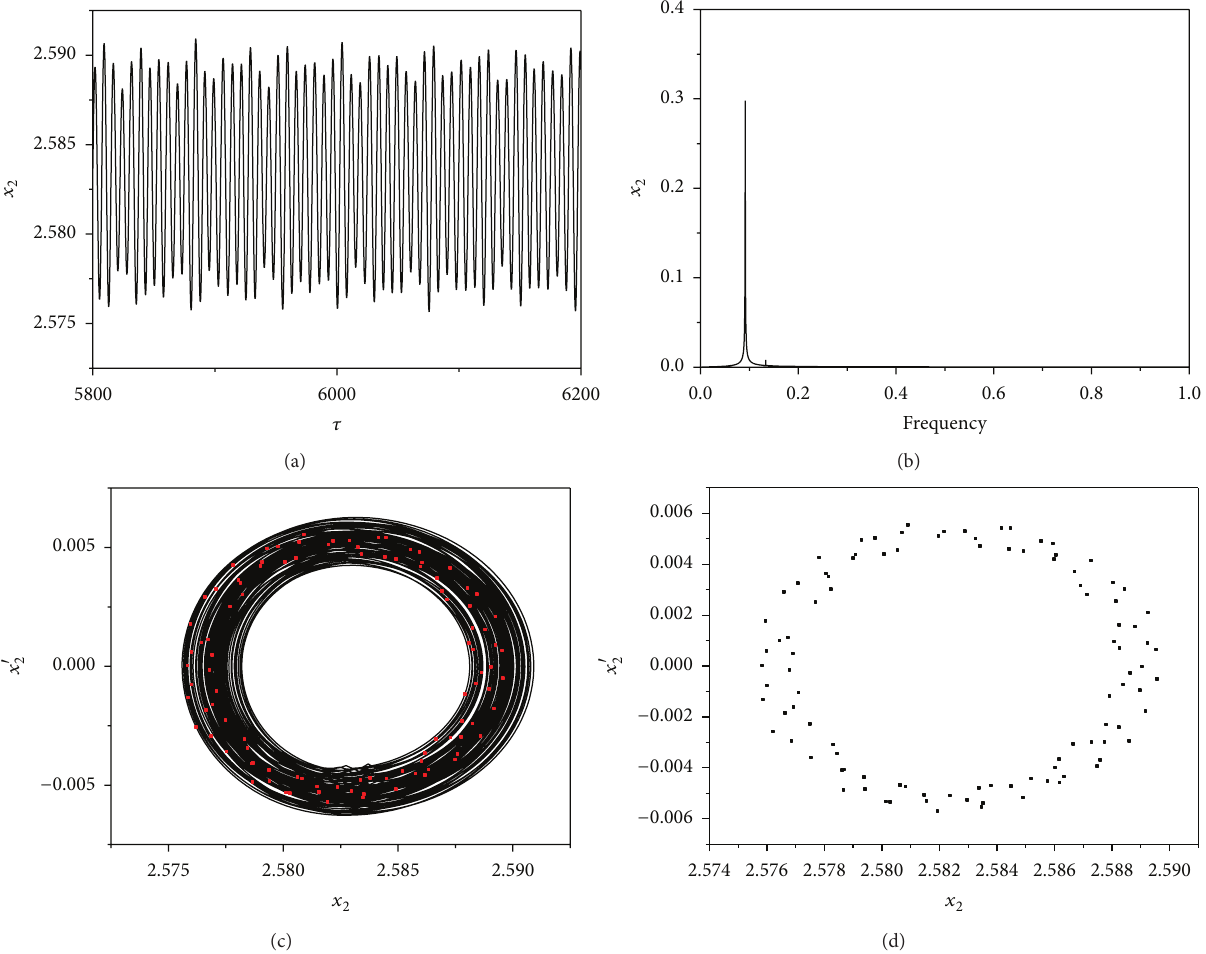
Figure 13: See 𝜔 = 1.10 . (a) Displacement response. (b) Frequency spectrum. (c) Phase-portrait plots. (d) Poincar´e